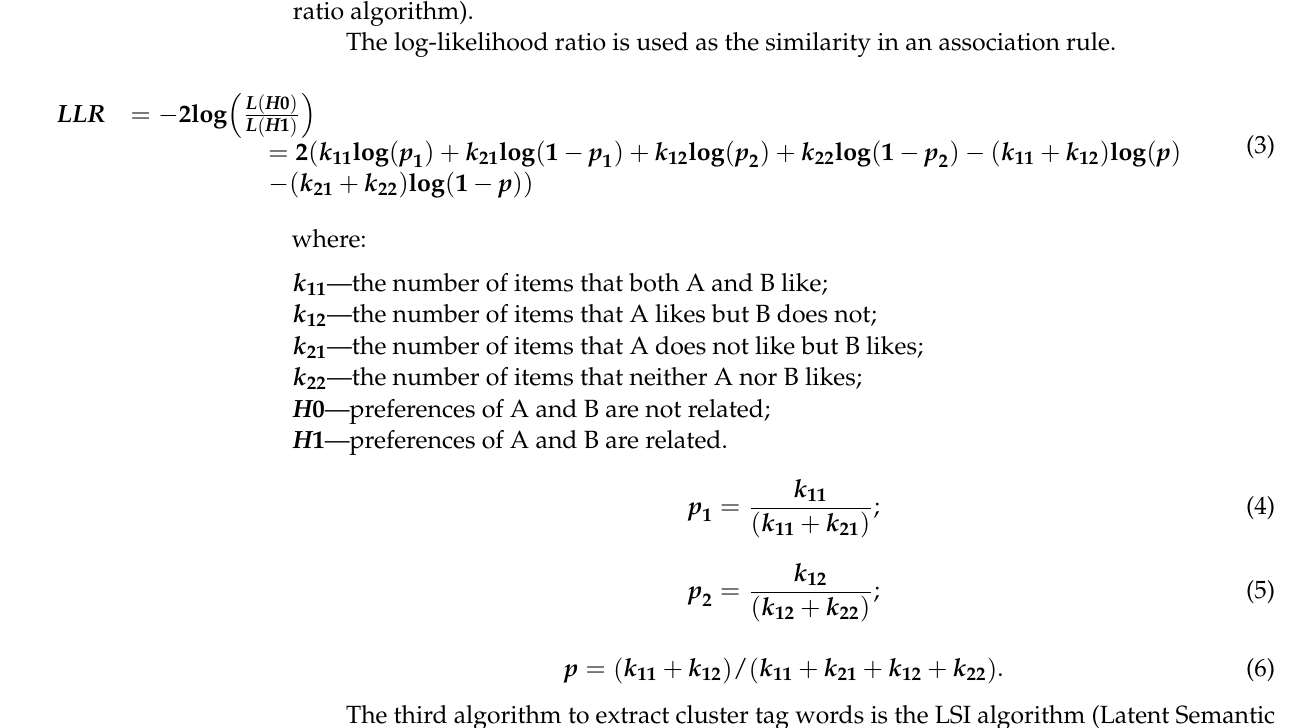
The third algorithm to extract cluster tag words is the LSI algorithm (Latent Semantic Indexing